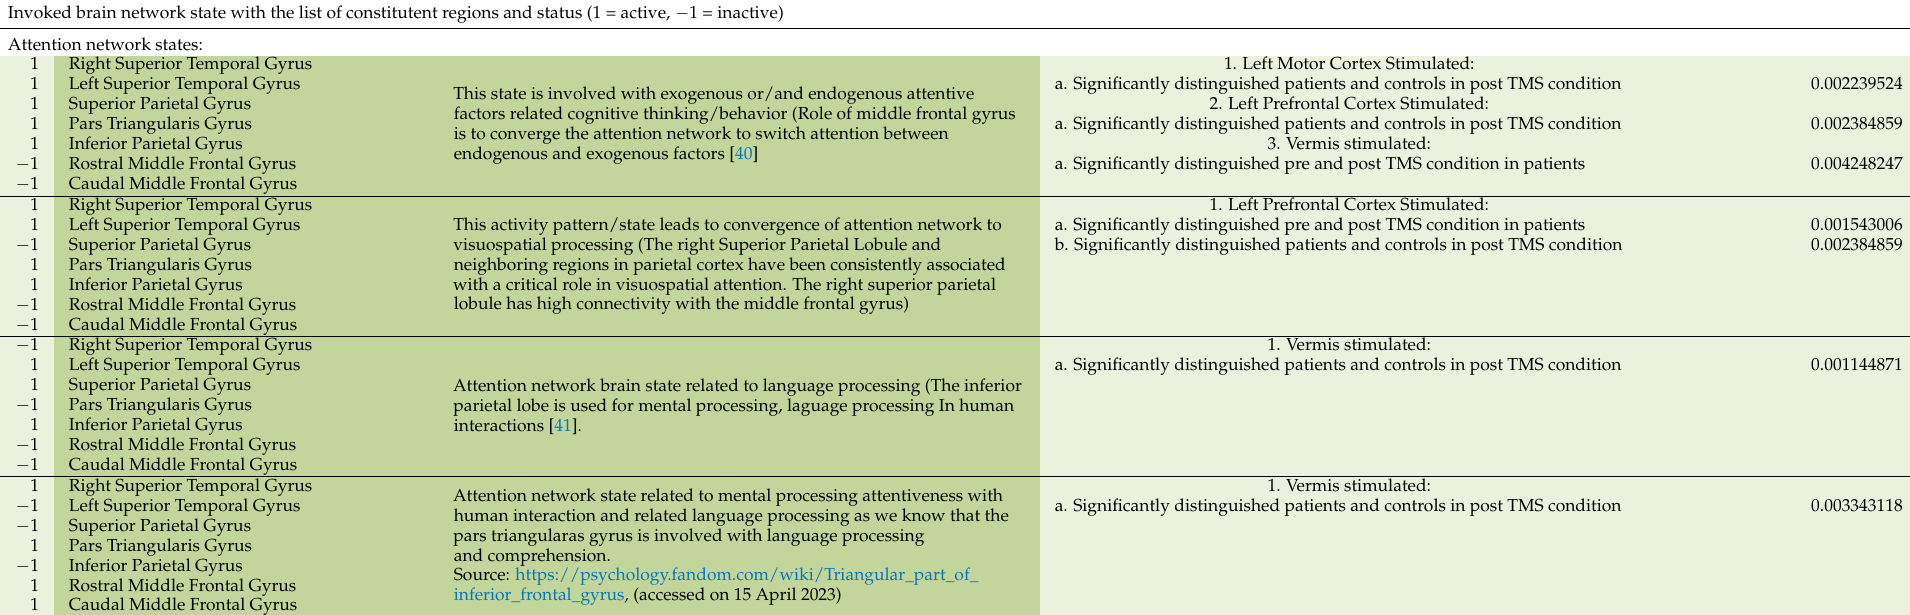
Table 5. Connectivity network state summary for the states of the attention network when the left motor, left prefrontal cortex and vermis are stimulated by the TMS subthreshold